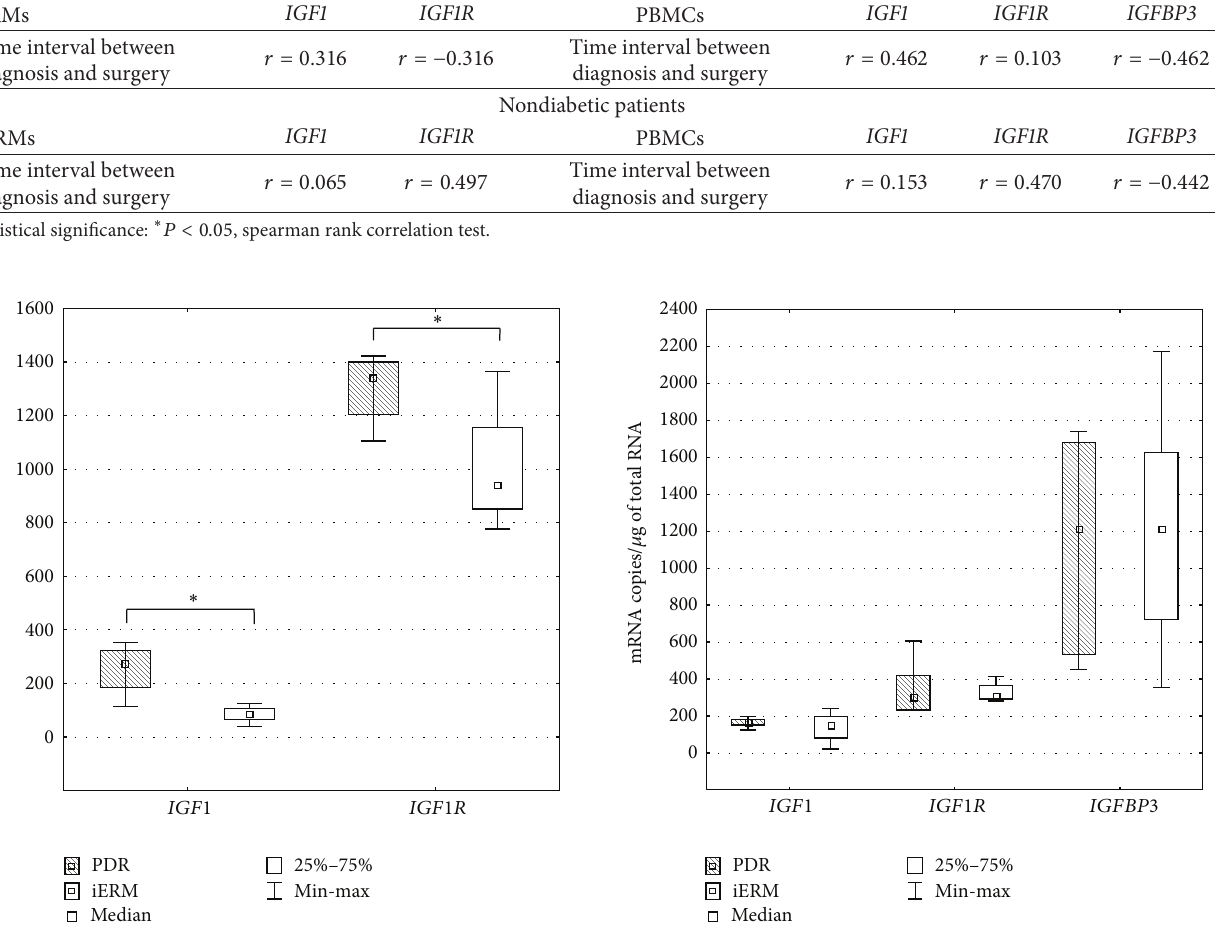
Figure 2: The mRNA levels of IGF1 , IGF1R , and IGFBP3 in periph- eral blood mononuclear cells of patients with proliferative diabetic retinopathy (PDR) and in the control subjects with idiopathic ERMs (iERM). (Box and whisker plots present medians ± quartiles and extreme values of copy numbers per 1 𝜇 g of total RNA, statistical significance: ∗ 𝑃 < 0.05 , Mann-Whitney 𝑈